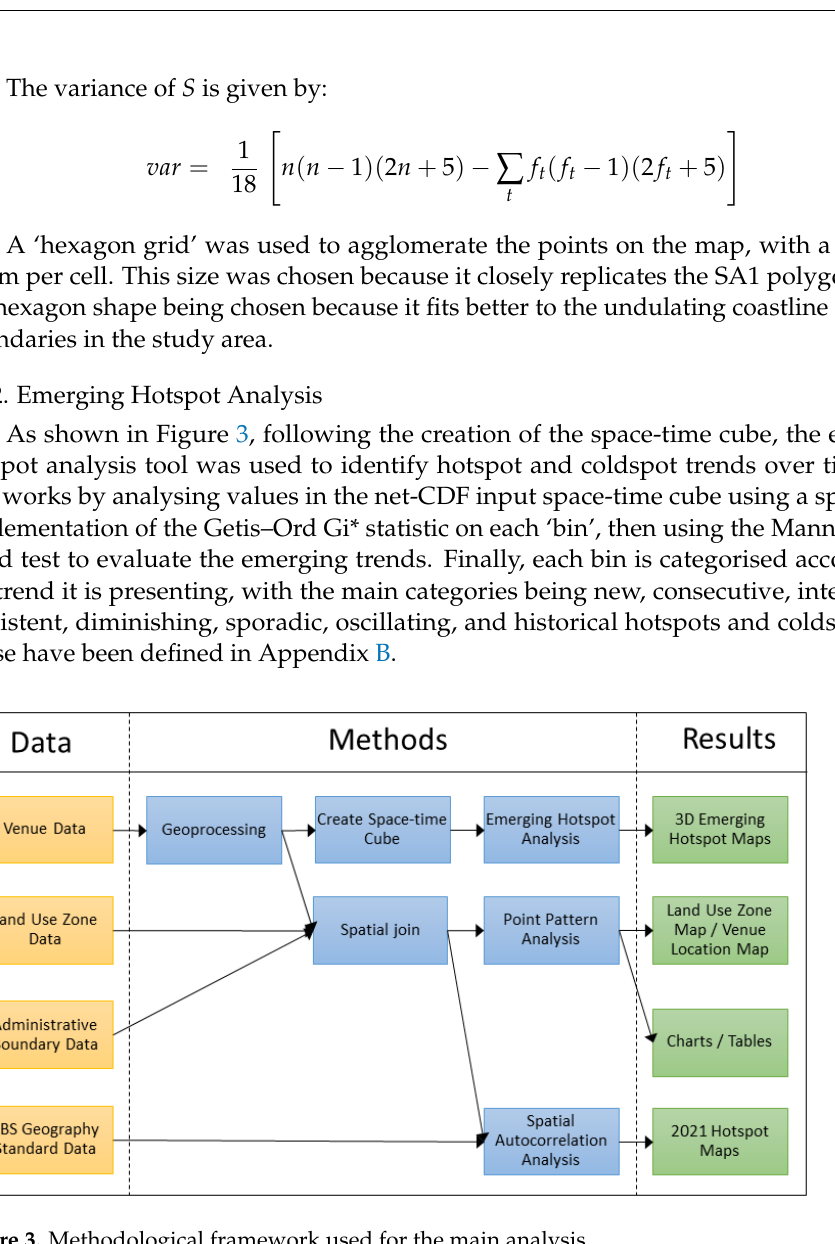
Figure 3. Methodological framework used for the main analysis.